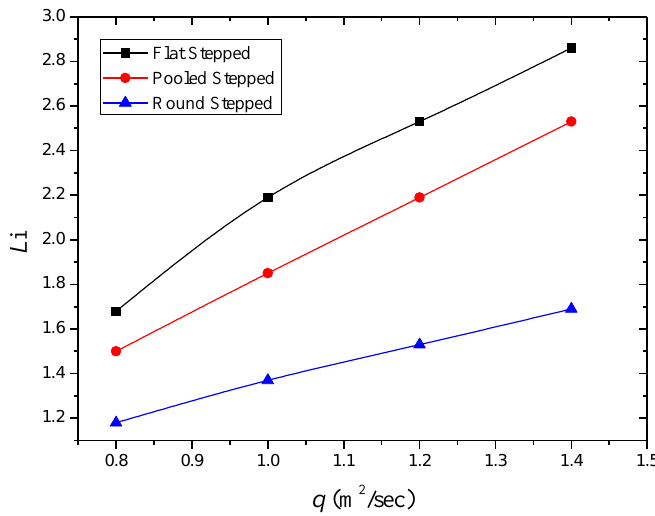
Figure 9. Comparison of relationship of inception length and unit discharge for the flat, pooled, and round stepped spillway models.